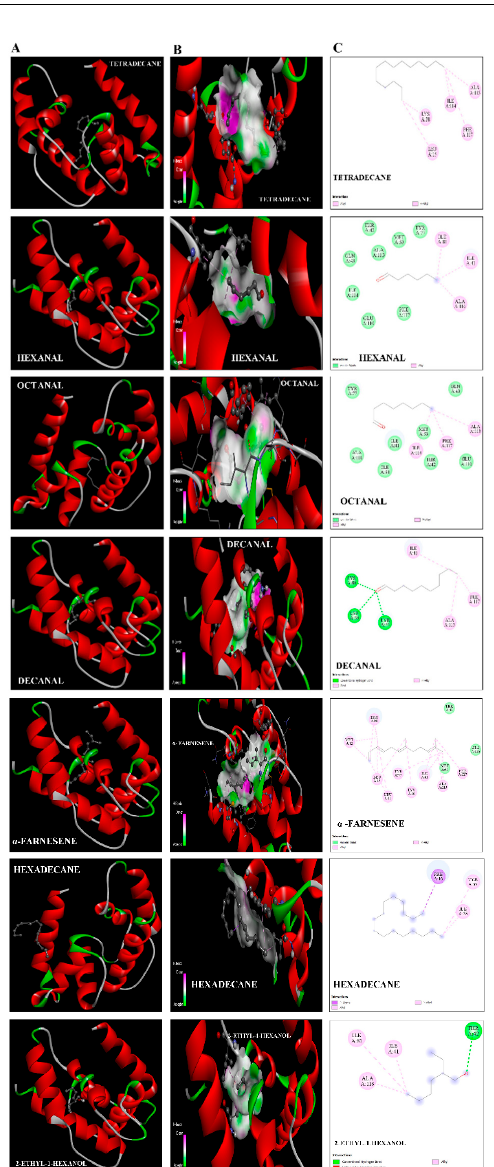
Figure 7. The interaction illustration and binding models of SaveOBP9. ( A ) Three-dimensional predicted interaction view with SaveOBP9 residues by molecular docking. ( B ) Binding cavity of ligands inside active site of SaveOBP9. Red and green amino acids represent the polar and nonpolar, respectively. ( C ) Two-dimensional predicted interaction of SaveOBP9.